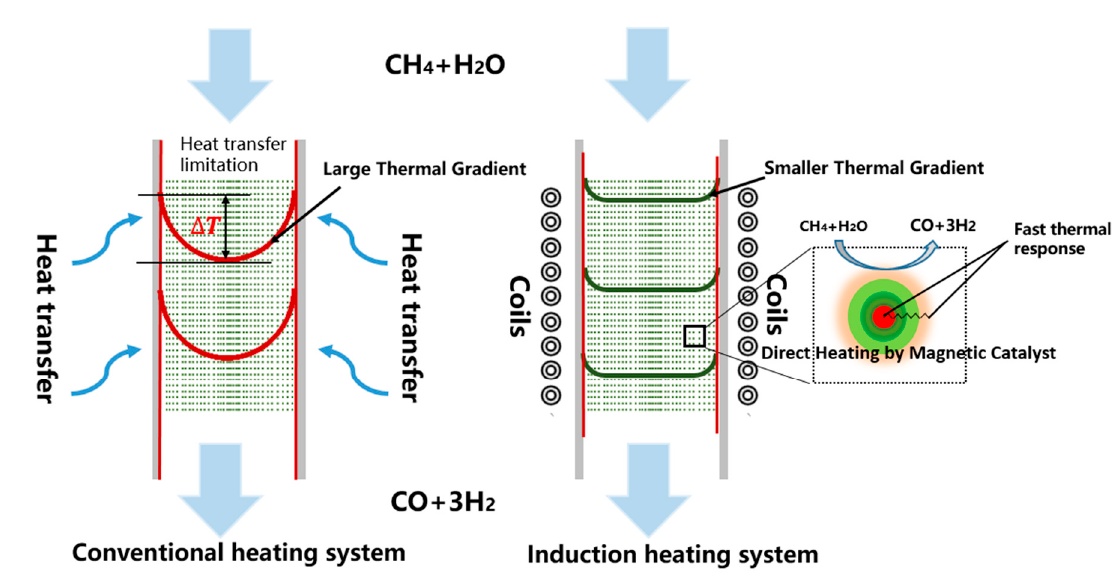
Figure 11. Different heating ways comparison chart.